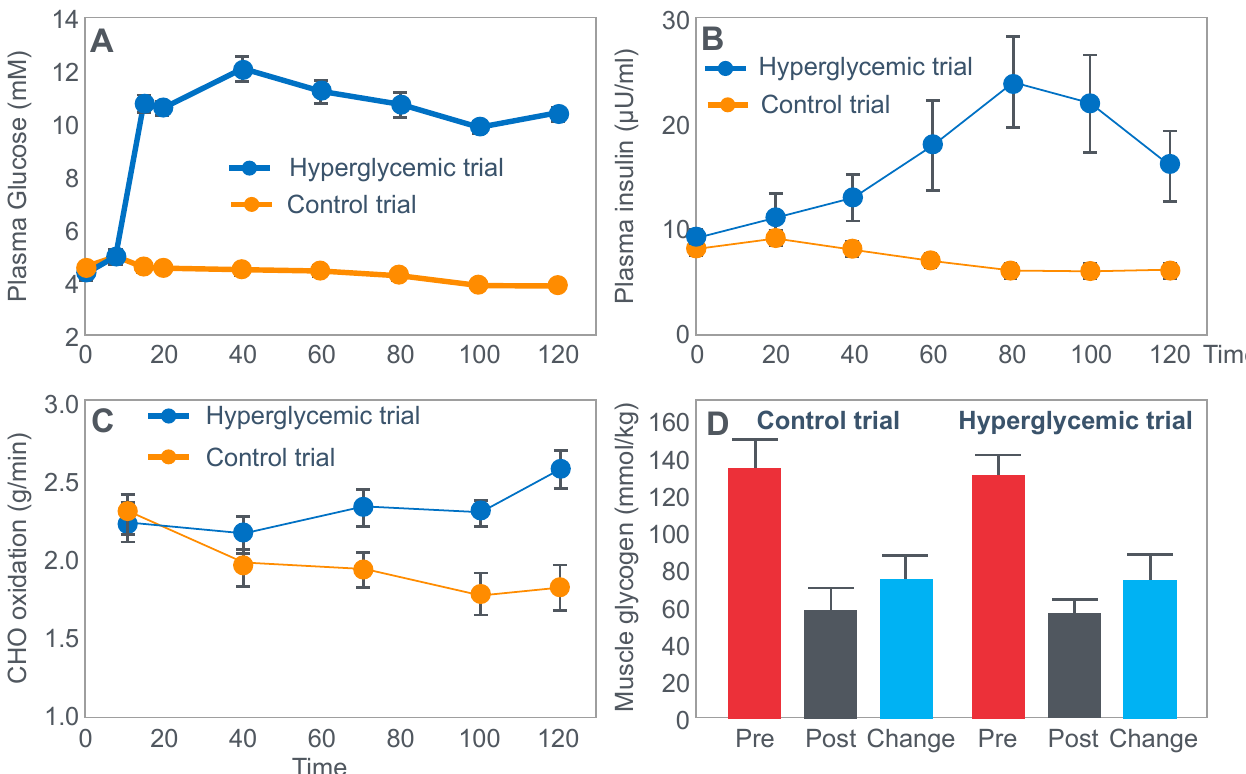
Figure 11. Changes in plasma glucose (panel A ) and plasma insulin concentrations (panel B ), in rates of carbohydrate oxidation (panel C ) and in muscle glycogen concentration before and after exercise, including muscle glycogen change (panel D ), in athletes who exercised for 120 min with or without a glucose infusion that produced profound hyperglycemia. Note that unlike the response shown in Figure 10, subjects in this study did not develop hypoglycemia during the control condition even though they had fasted for 12–14 h before exercise but had eaten a high-carbohydrate diet. Adapted with permission from ref. [64]. Copy-right 1991 American Physiological Society.